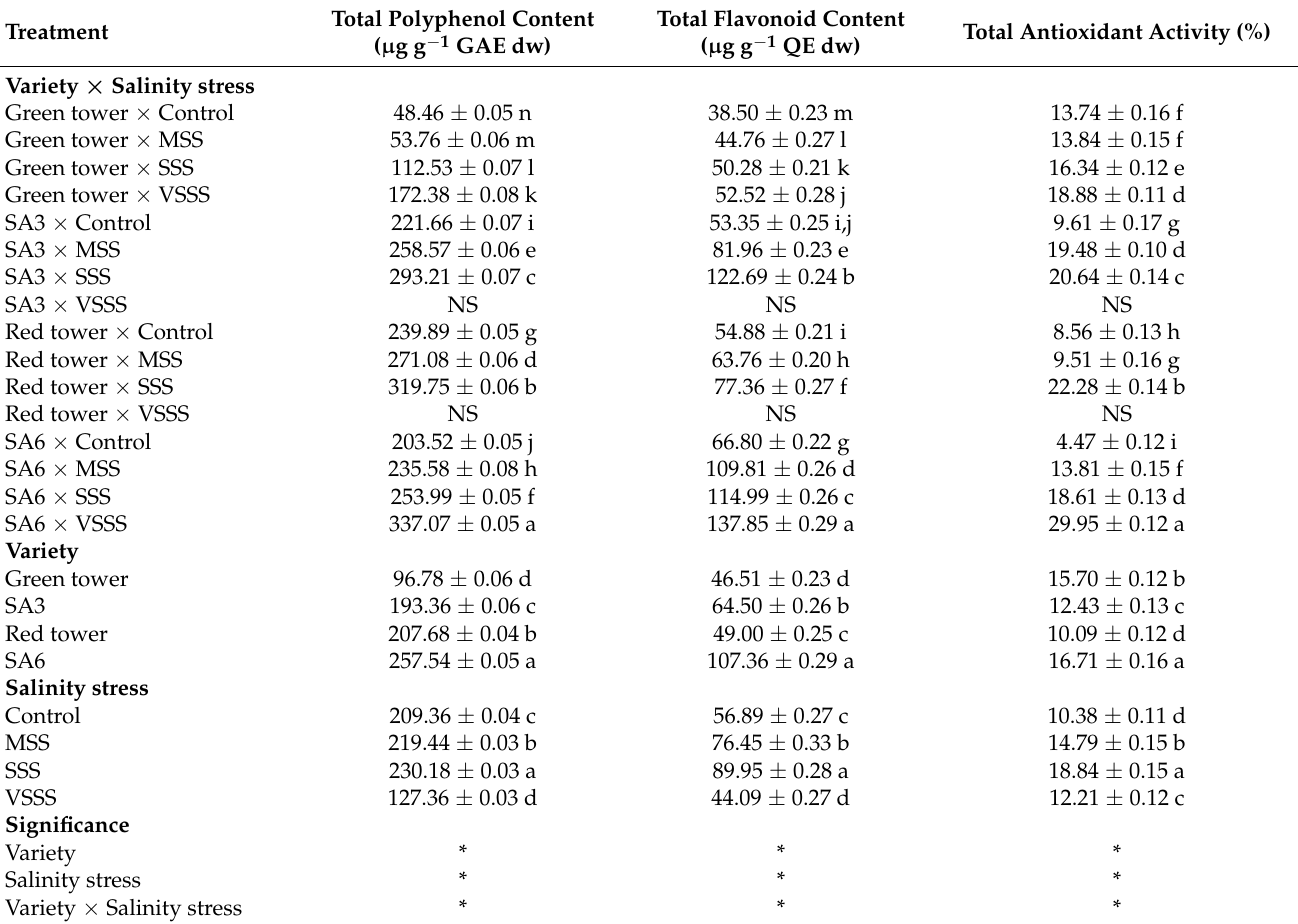
Table 4. Impact of salinity stress on total polyphenol content, total flavonoid content, and total antioxidant activity of four selected genotypes of A. lividus leafy